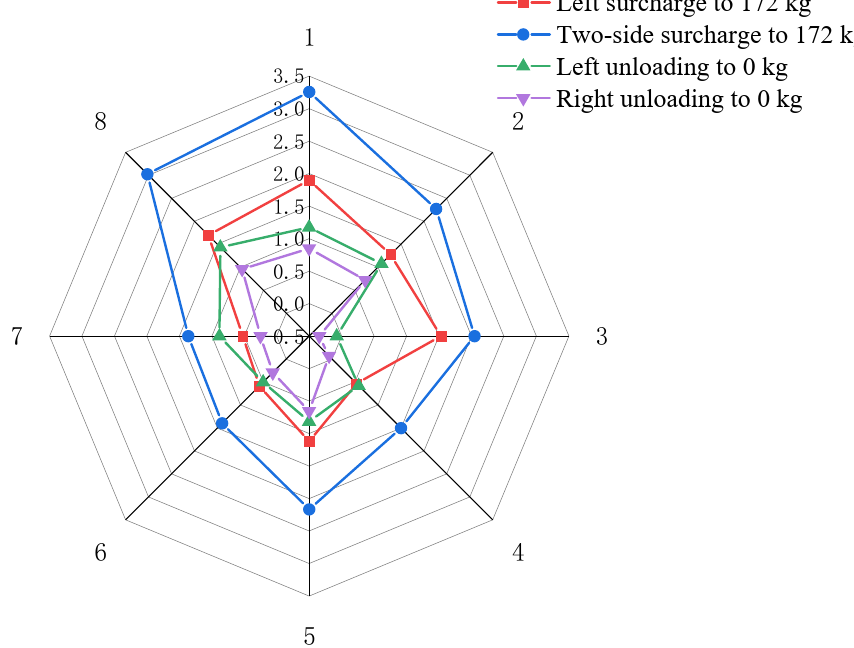
Figure 13. Variation in additional surrounding pressure under different surcharges for Case 1 (unit: kPa).